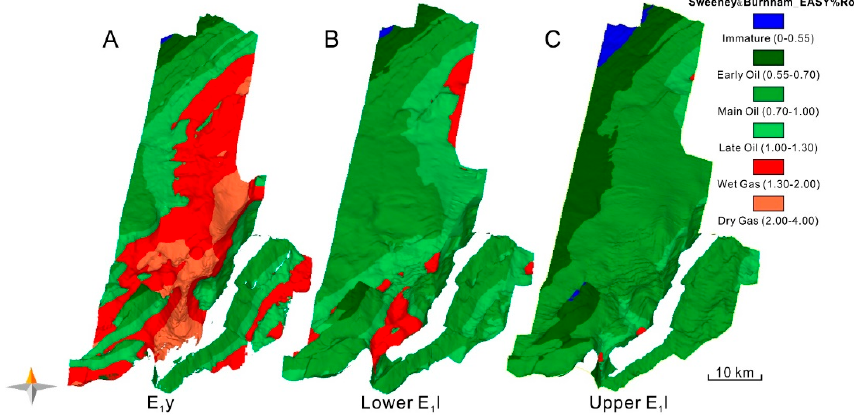
Figure 14. ( A ) Modelled maturity maps at present day for the E 1 y; ( B ) Modelled maturity maps for the Lower E 1 l; ( C ) Modelled maturity maps for the Upper E 1 l. The higher maturities have been reached in the central part of the west sub-sag. The missing area between the sub-sags represents the Lingfeng Uplift.